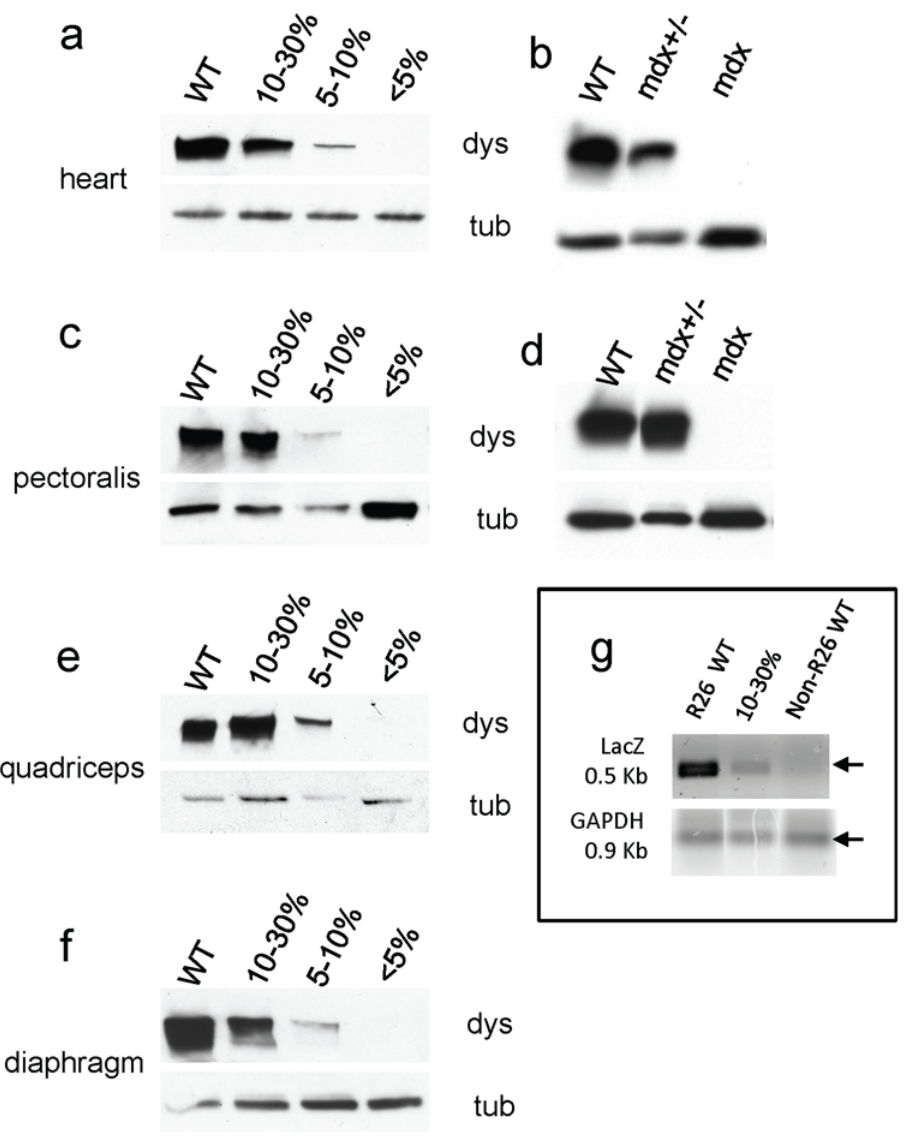
Figure 7. WT/mdx chimeric muscle overproduces dystrophin. a, c, e and f, protein extracts from hearts (a), pectoralis (c), quadriceps (e) and diaphragms (f) of WT, 10–30% WT/mdx, 5–10% WT/mdx and , 5% WT/mdx mice were subjected to a western blot for dystrophin and tubulin (load control). Band intensities (dystrophin/tubulin) were scanned and values relative to WT (100%) are presented in Table I. b, d, protein extracts from hearts (b) or pectoralis muscles (d) of WT, mdx + / 2 and mdx mice were subjected to a western blot for dystrophin and tubulin. Western blots were performed with extracts of hearts and various muscles (pectoralis, quadriceps and diaphragm) from 2–4 animals per group (WT [n=3], mdx + / 2 [n=2], 10–30% [n=4], 5–10% [n=2], , 5% [n=4] and mdx [n=3]). g, DNA from 10–30% (n=4) R26 WT/mdx, R26 WT (n=2) and non-R26 WT (n=3) mice were isolated from quadriceps muscles and subjected to semi-quantitative PCR using primers for LacZ or GAPDH. Note in that the 10–30% quadriceps muscle shows normal levels of dystrophin (relative to WT) (e) but only a fraction of LacZ-positive DNA (relative to R26 WT)